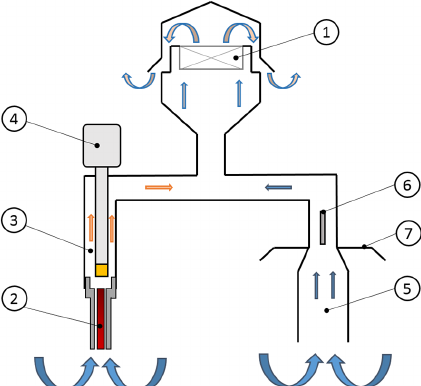
Figure 2. Schematic drawing of the modified (HMPmod) hygrome- ter. The air is aspirated by the fan (1) and heated through an inlet (2). The temperature and the moisture content of the heated air (3) is measured by the HMP155 (4). The ambient air temperature (5) is measured by a separate PT100 (6) located in the unheated aspirated inlet shaded from sun radiation